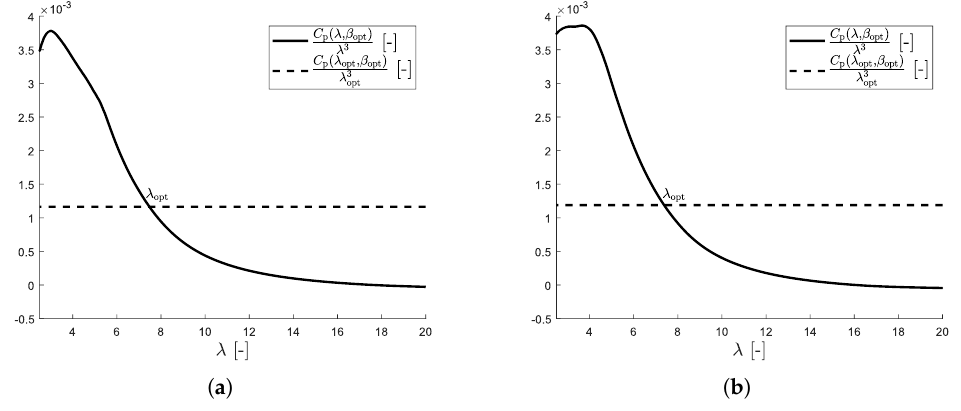
Figure 4. Optimal tip-speed ratio stability criterion for NREL 5-MW ( a ) and DTU 10-MW ( b ) reference